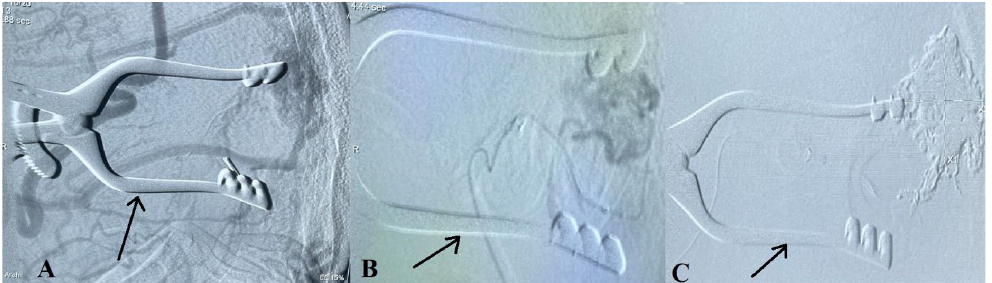
Figure 5. A carotid angiogram ( A ) after occipital craniotomy showing the AVM. Superselective angiography image from middle meningeal artery afferent ( B ). Angiogram view after embolization ( C ). Jansen retractor marked by the arrow.